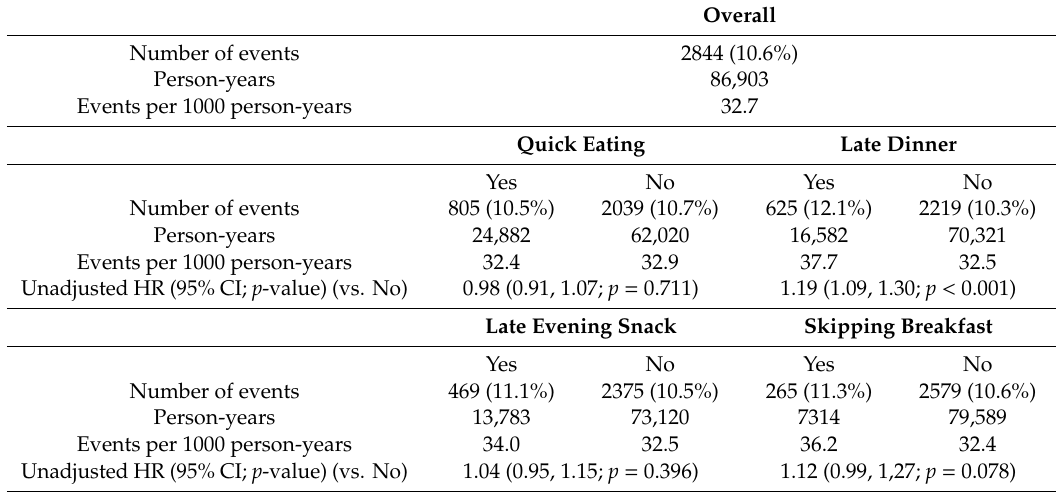
Table 2. Association between unhealthy dietary habits and hazard ratio of proteinuria onset.